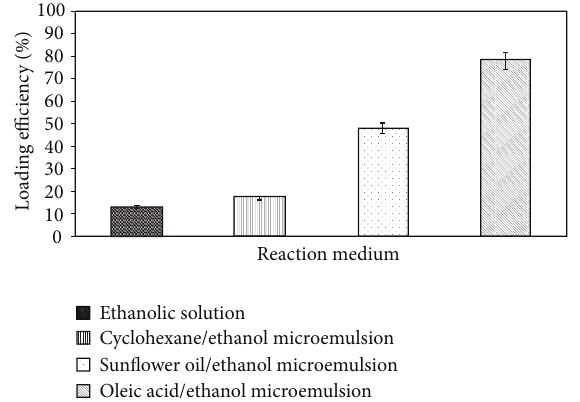
Figure 4: Effect of reaction medium on loading efficiency of curcumin onto starch nanoparticles.